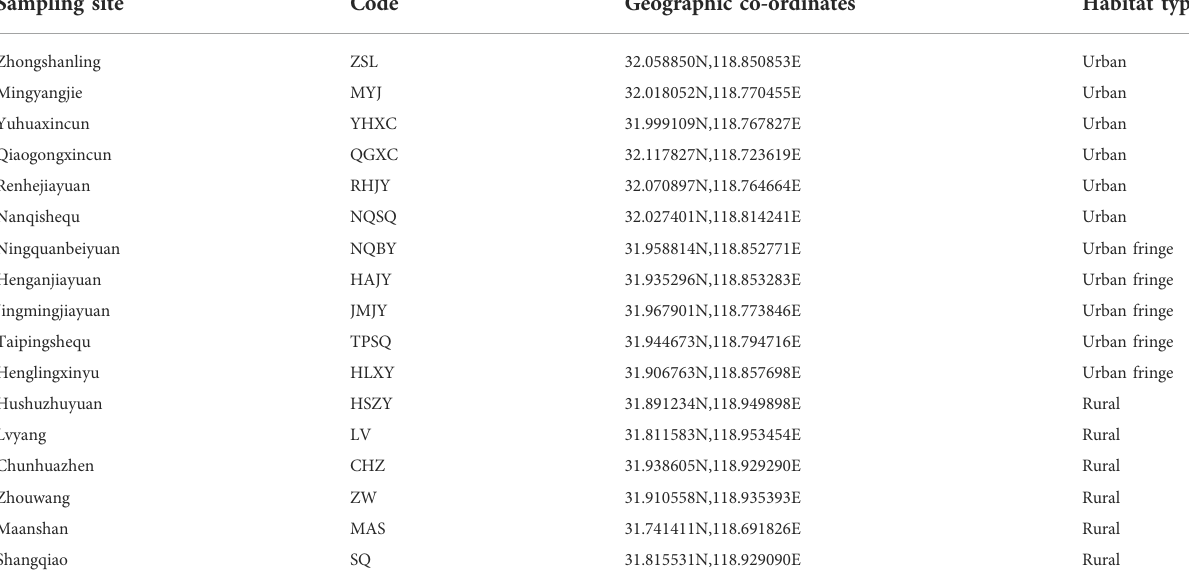
TABLE 1 Location names, geographic coordinates and habitat type of all 17 Ae. albopictus sampling